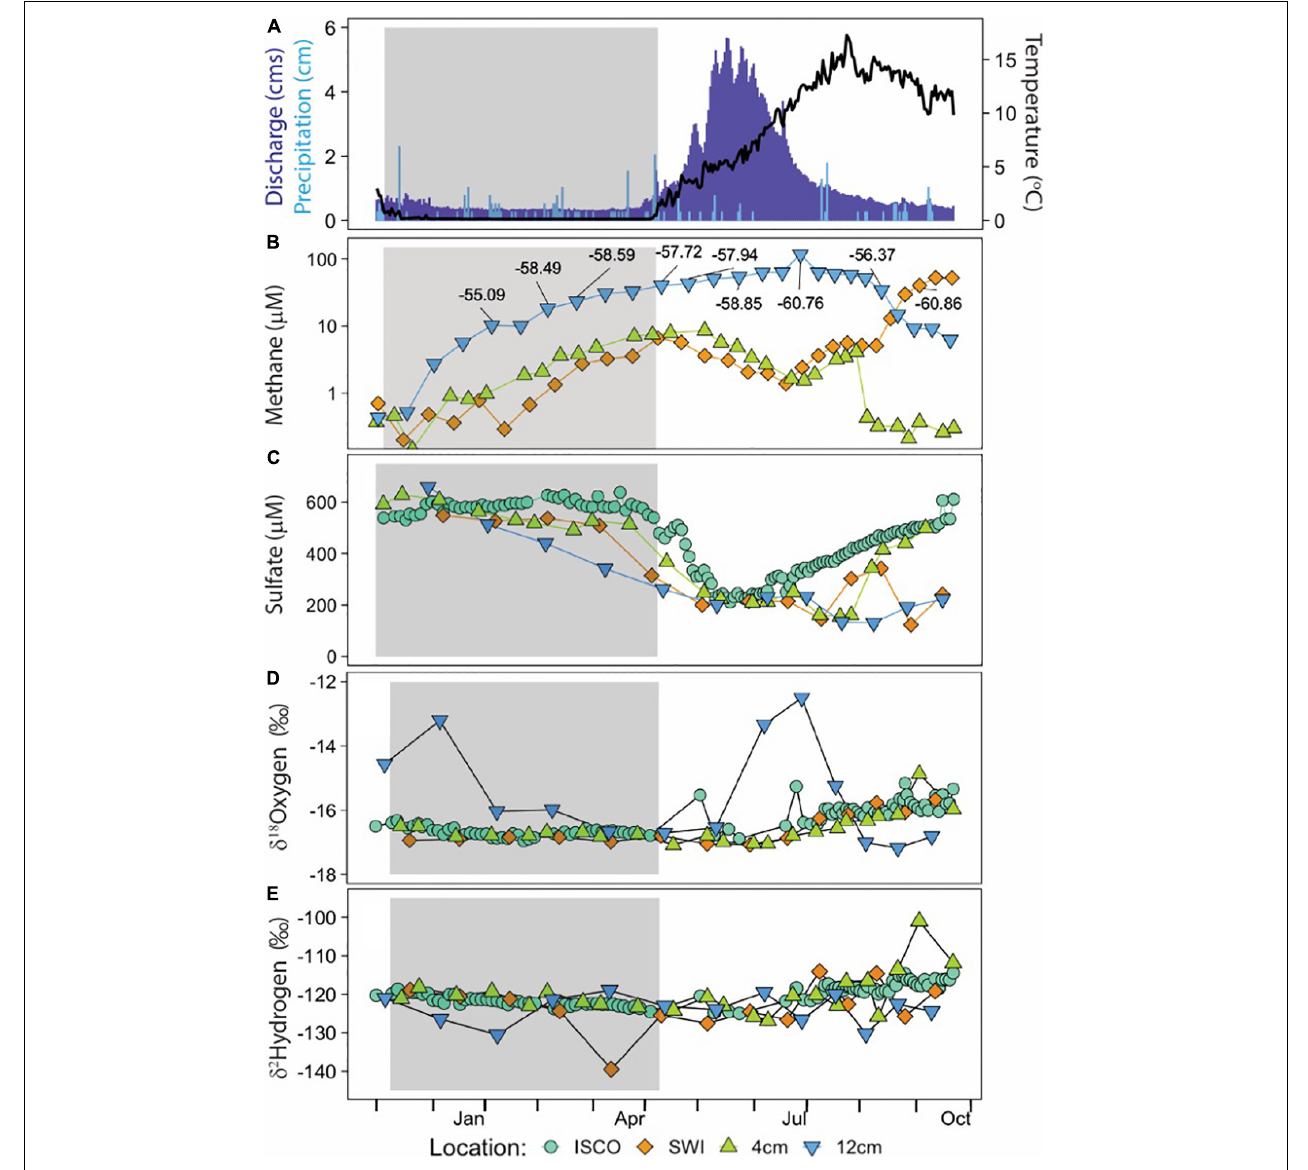
FIGURE 3 | Time-series data from ER OsmoSamplers and ISCO sampler. Gray shaded areas represent the time of year ER experienced ice cover. (A) Rosemary and Williams (2019) reported discharge in cubic meters per second (cms) in dark blue bars for ER, near Crested Butte, CO. Precipitation increments shown in light blue bars, from NRCS SNOTEL site 380. Water temperature data from HOBO anchored next to OsmoSamplers indicated by black data line. (B) Continuous, integrated methane concentration measured by the OsmoSamplers. Label boxes indicate δ 13 C-CH 4 values for individual CH 4 measurements 12 cm into the HZ and at the SWI. (C) Sulfate discrete (ISCO sampler) and continuous (OsmoSampler) solute concentration. δ 18 O-H 2 O (D) and δ 2 H-H 2 O (E) isotopes. Data from the ISCO sampler are from the water column (blue circle). OsmoSampler samples from 12 cm (blue triangle) and 4 cm (green triangle) are from within the hyporheic zone; samples from the sediment water interface are represented by orange diamond. Please note the difference in scales on the y